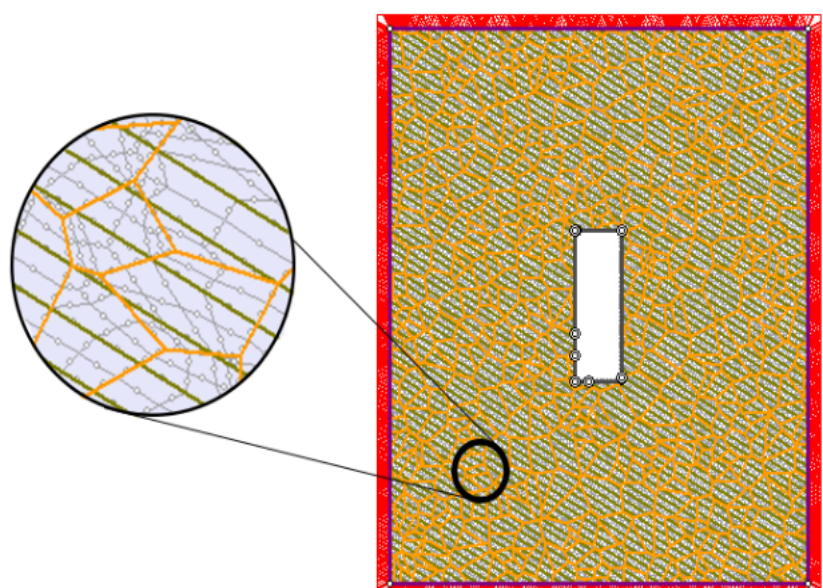
Figure 4. Portion of the numerical model in RS2, illustrating the second examined case of the “joint set number” parameter.